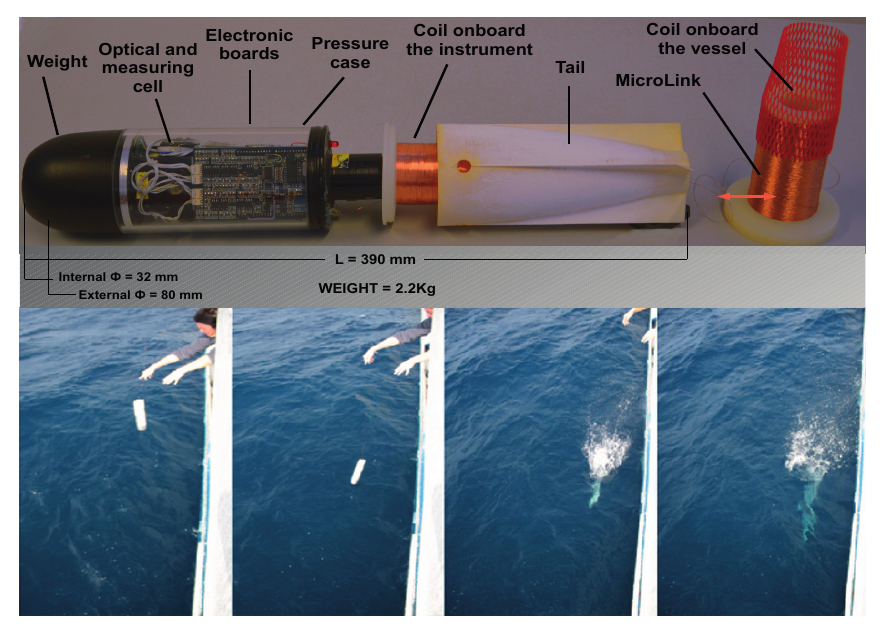
Figure 8. A new T-FLaP prototype with a transparent case for electronic visualization and the launch during ADR0208